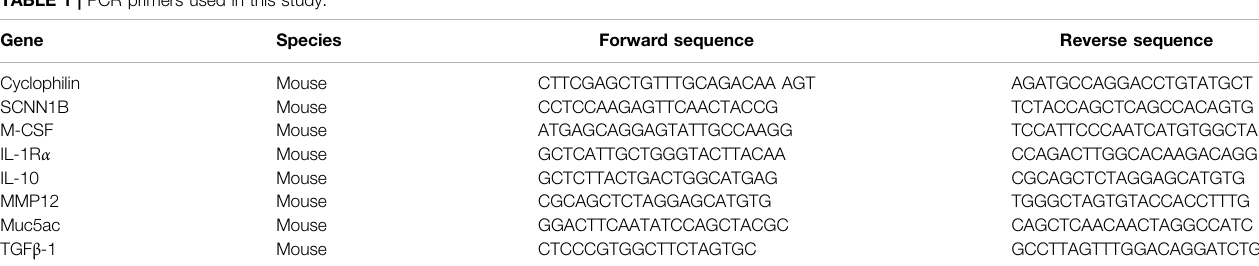
TABLE 1 | PCR primers used in this